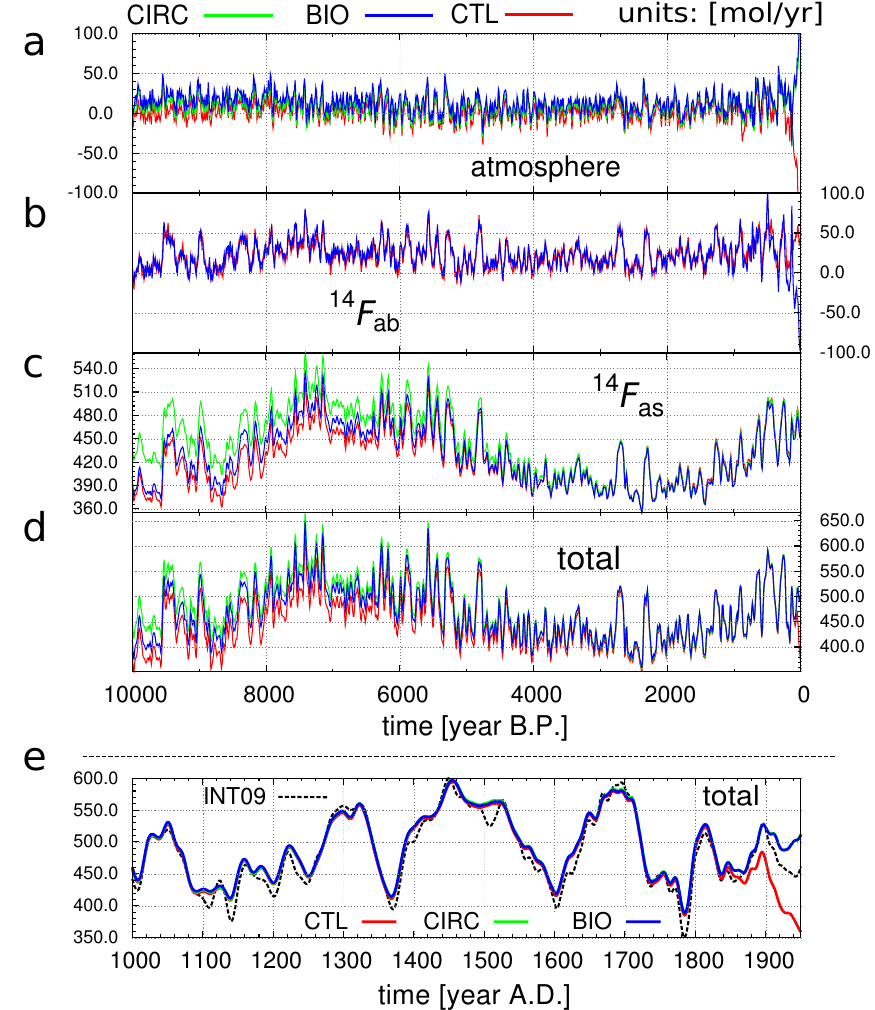
Fig. 8. Holocene 14 C fluxes in mol 14 Cyr − 1 for the different experiments: (a) changes and decay of the atmospheric inventory (including F budget ), (b) air–biosphere flux ( F ab ), (c) air–sea flux ( F as ) and (d) the sum of these contributions yielding the total production rate Q . (e) shows the last 1000yr in greater detail together with an experiment (INT09) where the entire globe is forced with the Northern Hemisphere dataset IntCal09 (dashed line), thereby neglecting the interhemispheric gradient in 1 14 C. Note that the time series shown in (a) and (b) have been smoothed with a cutoff of 40yr (only for the visualisation) while (c) – (e) show 20yr smoothed data as described in the main text.